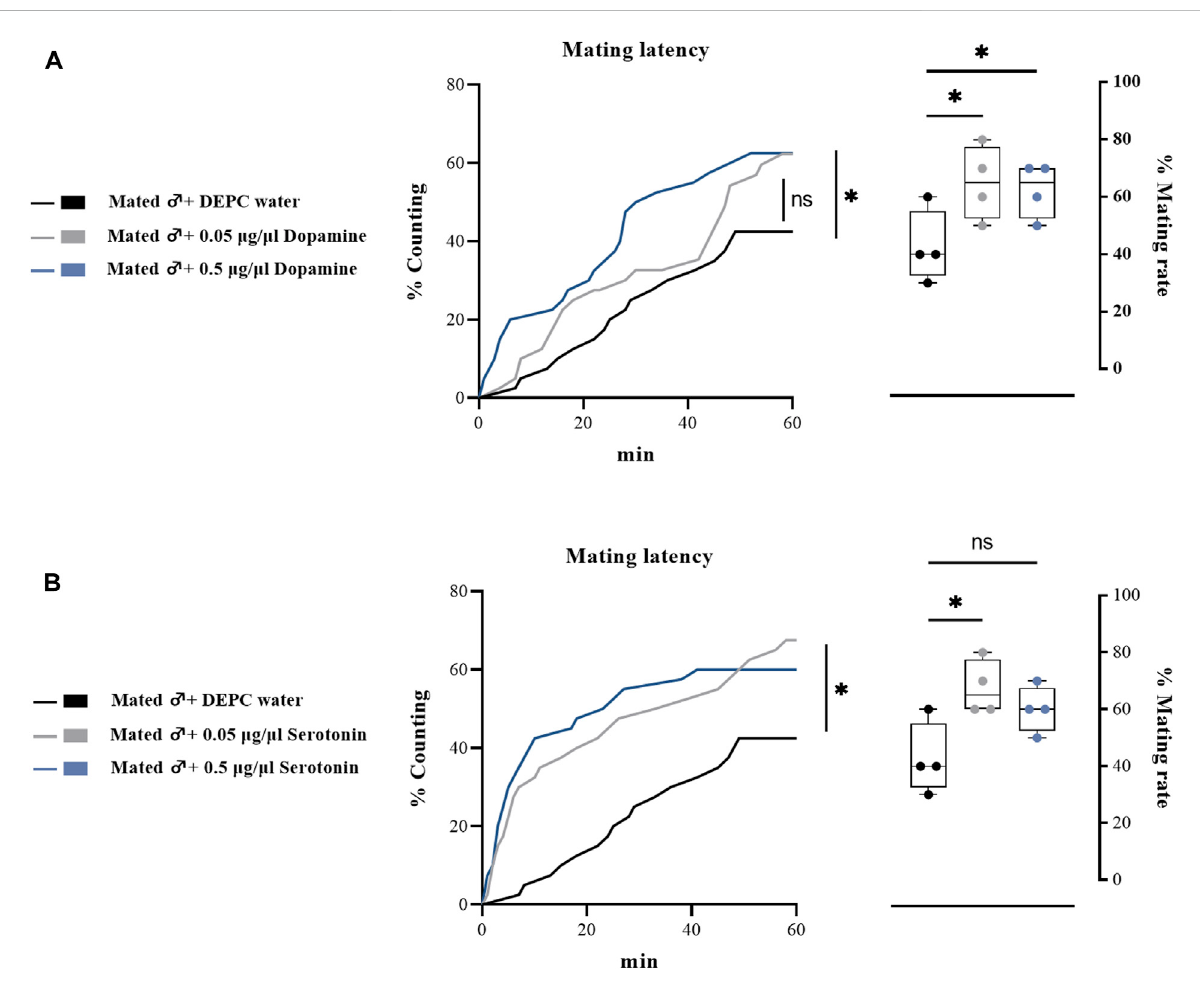
FIGURE 5 Changes in mating latency and mating rates following pharmacological treatments in mated male fl ies. Mating assays were performed at 2 h after biogenic amine-injection in mated male fl ies (13th day post emergence). DEPC water treatment was served as control. For treatment groups, 0.05 μ g/ μ l dopamine (A) , and serotonin (B) were injected, respectively. Values are the means (± SEs) of replicates. Statistical comparisons were conducted by comparing each treatment with control, respectively, and based on Log-rank (Mantel-Cox) test (mating latency) and Students ’ s t test (mating rate). The level of signi fi cance for the results was set at * p < 0.05, ** p < 0.01, *** p <